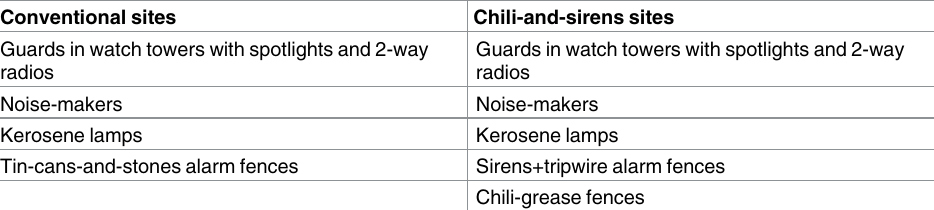
Table 1. Crop protection methods used in the ‘conventional’ sites and the ‘chili-and-sirens’ sites in Phases1 and 2. Conventional